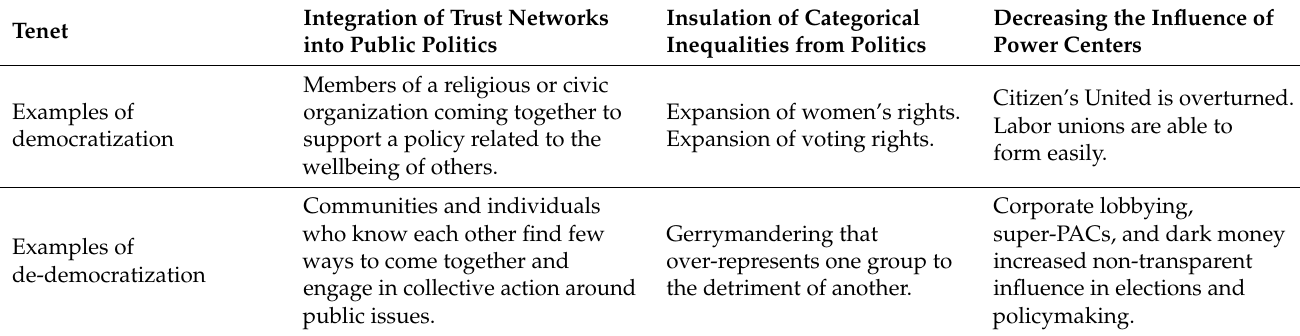
Table 1. Examples of Democratization